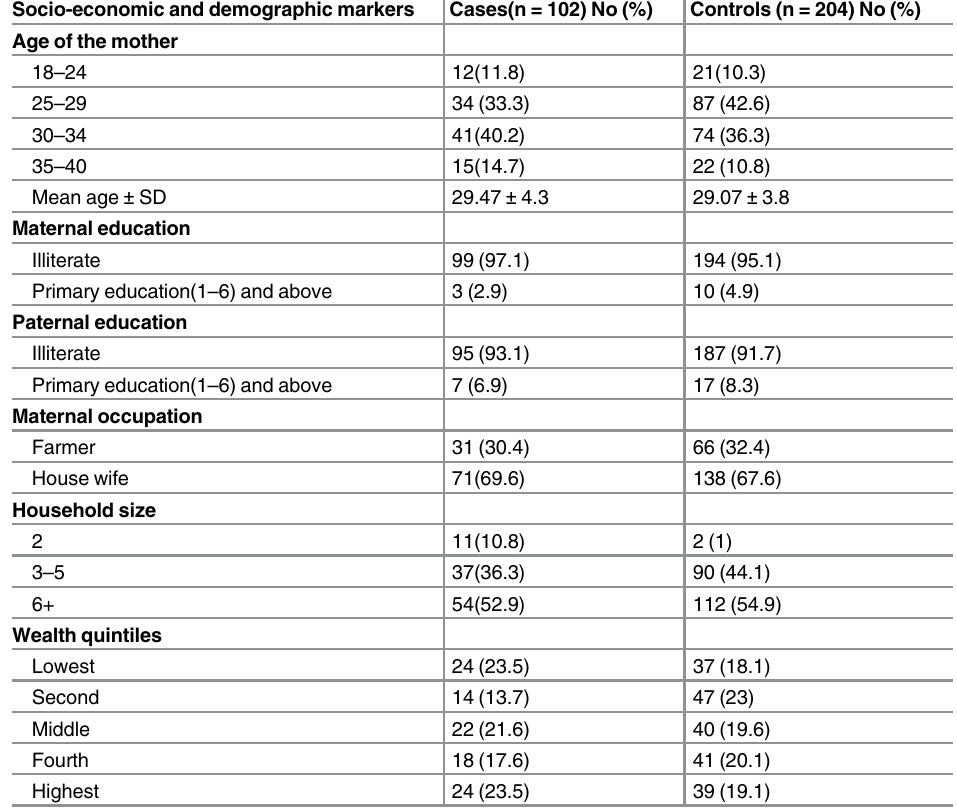
Table 1. Socio-economic and demographic variables of the participants in West Gojam zone, Ethio- pia, Feb 2012(n = 306). Socio-economic and demographic